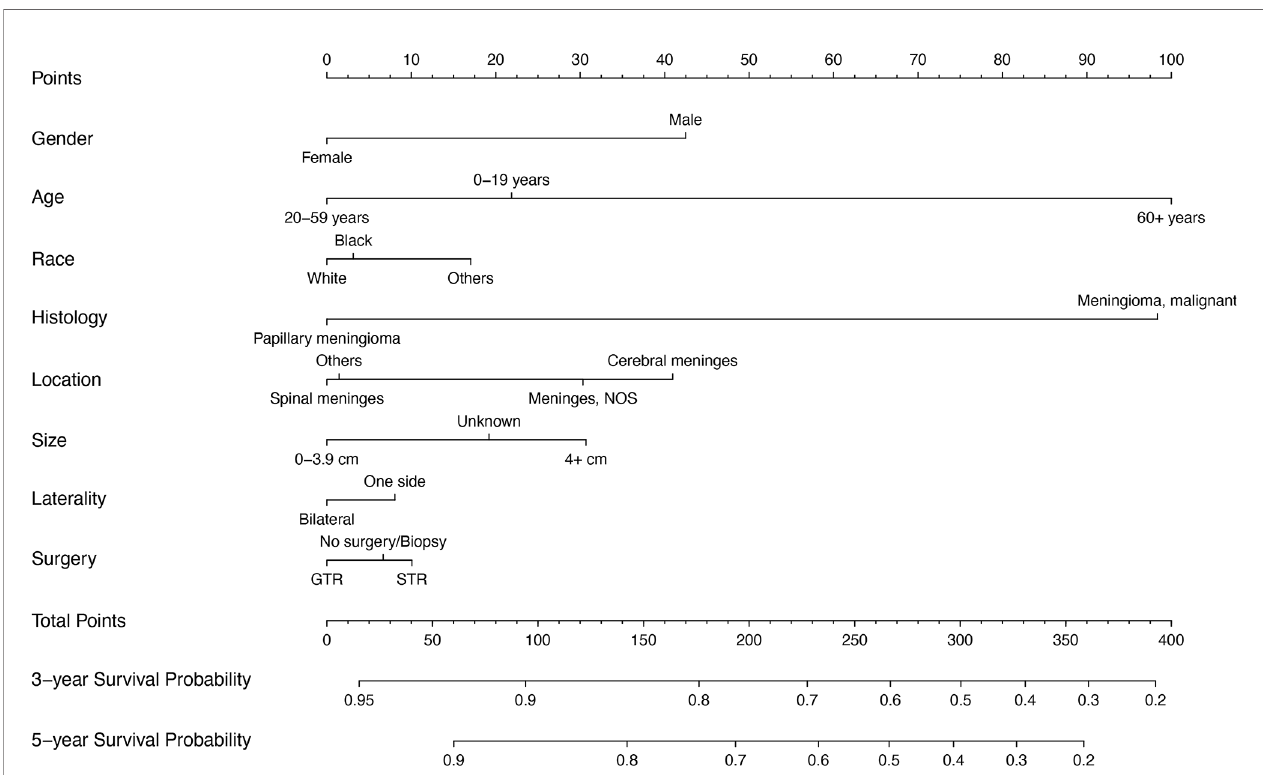
FIGURE 3 | Prognostic nomogram of WHO Grade III patients with meningioma based on 8 risk factors. NOS, not otherwise speci fi ed; STR, subtotal resection; GTR, gross total